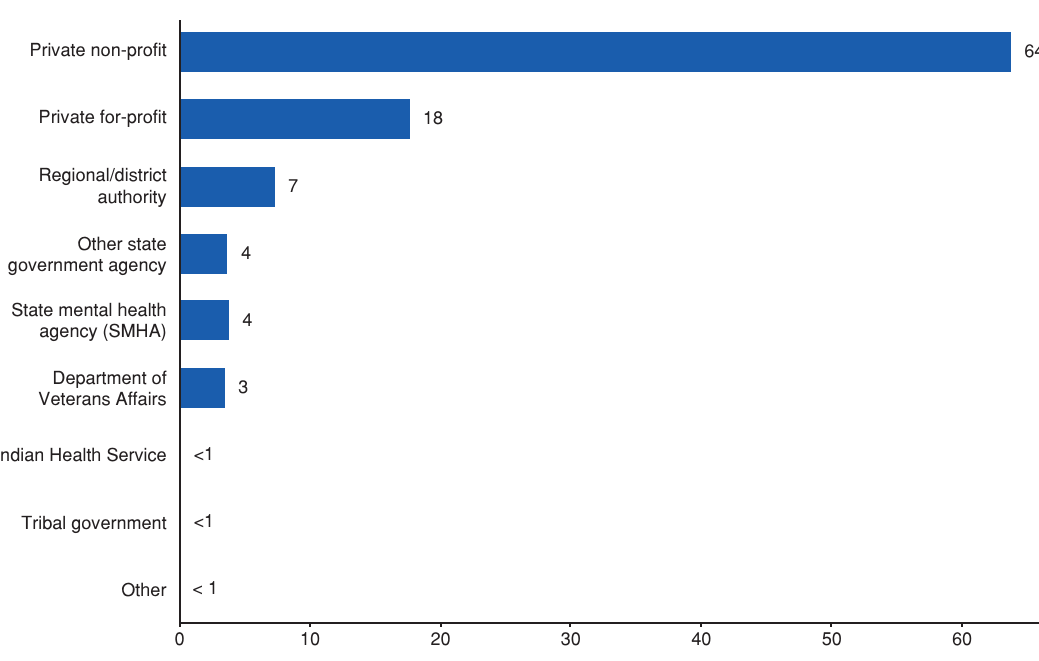
Figure 2. Facility operation: